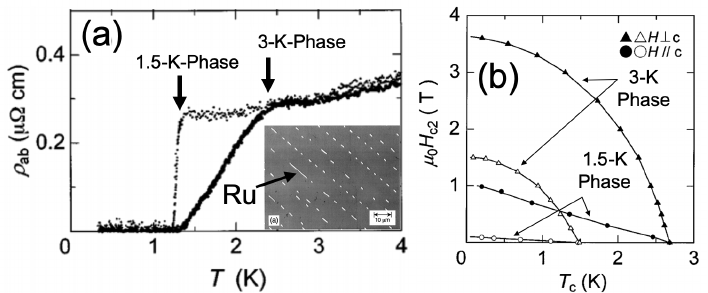
Figure 1. ( a ) Temperature-dependent-resistance R ( T ) of pure (grey line) and eutectic (black line) SRO214 single crystals. The eutectic crystal exhibits multiple phases: the 3-K- and 1.5-K-phase. ( b ) Lower ( H c1 ) and upper critical fields ( H c2 ) vs. temperature of the 3-K- and 1.5-K-phase. (Adopted with permission from [51] copyright APS